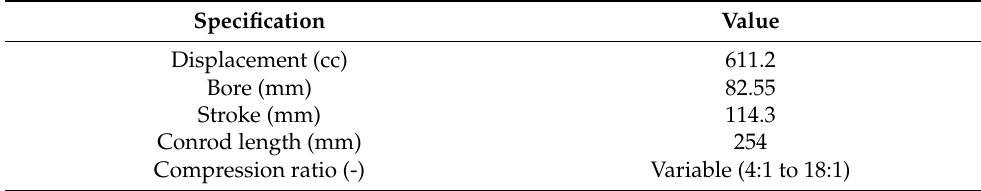
Table 2. Main geometric features of the CFR engine from [14].